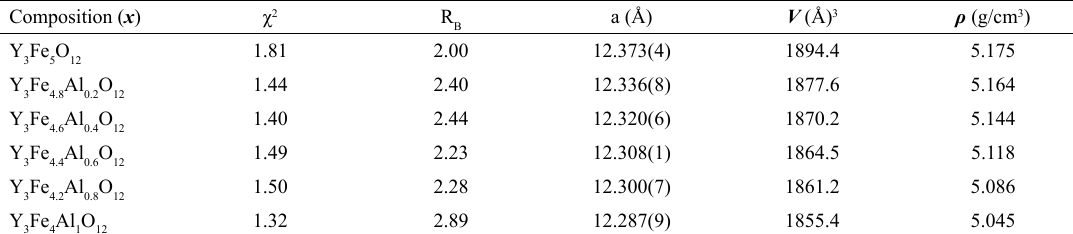
, χ 2 , lattice constant a , unit cell volume, and density ρ for all garnet Table 1. Bragg factor R B